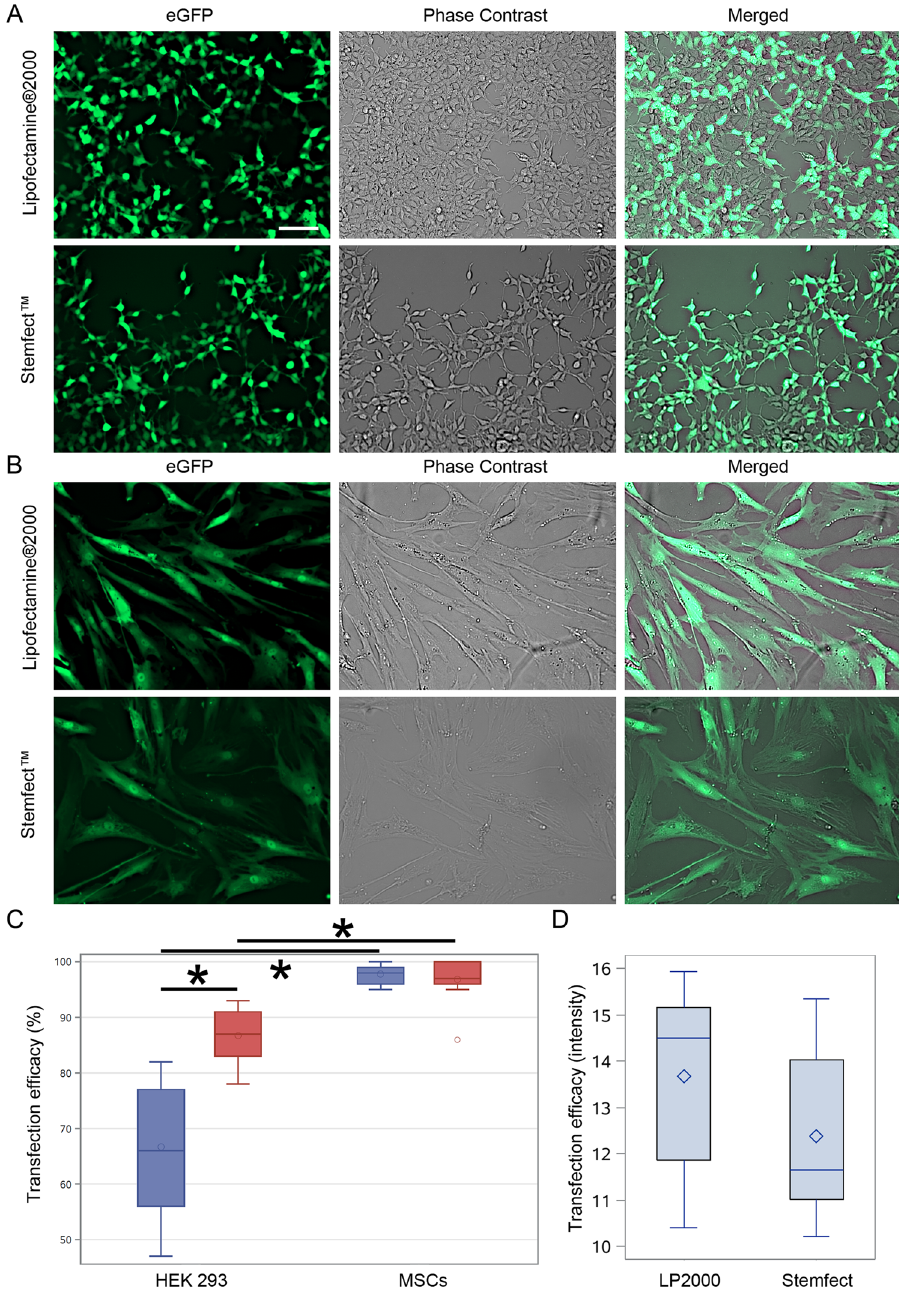
Figure 2. mRNA-based transfections of MSCs and HEK293 cells. The eGFP-mRNA transfection of HEK293 ( A ) and MSCs ( B ) with different transfection agents. Quantification of percentage of cells expressing transgenes ( C ). Quantification of pixel intensity in MSCs transfected with different agents ( D ). Green – eGFP protein. Error bars are box-and-whiskers plots containing the mean, quartiles (box) and minimum and maximum observations (whiskers). Transfection efficiencies have been calculated from three independent experiments. Scale bar located in the top left image: 20 µ